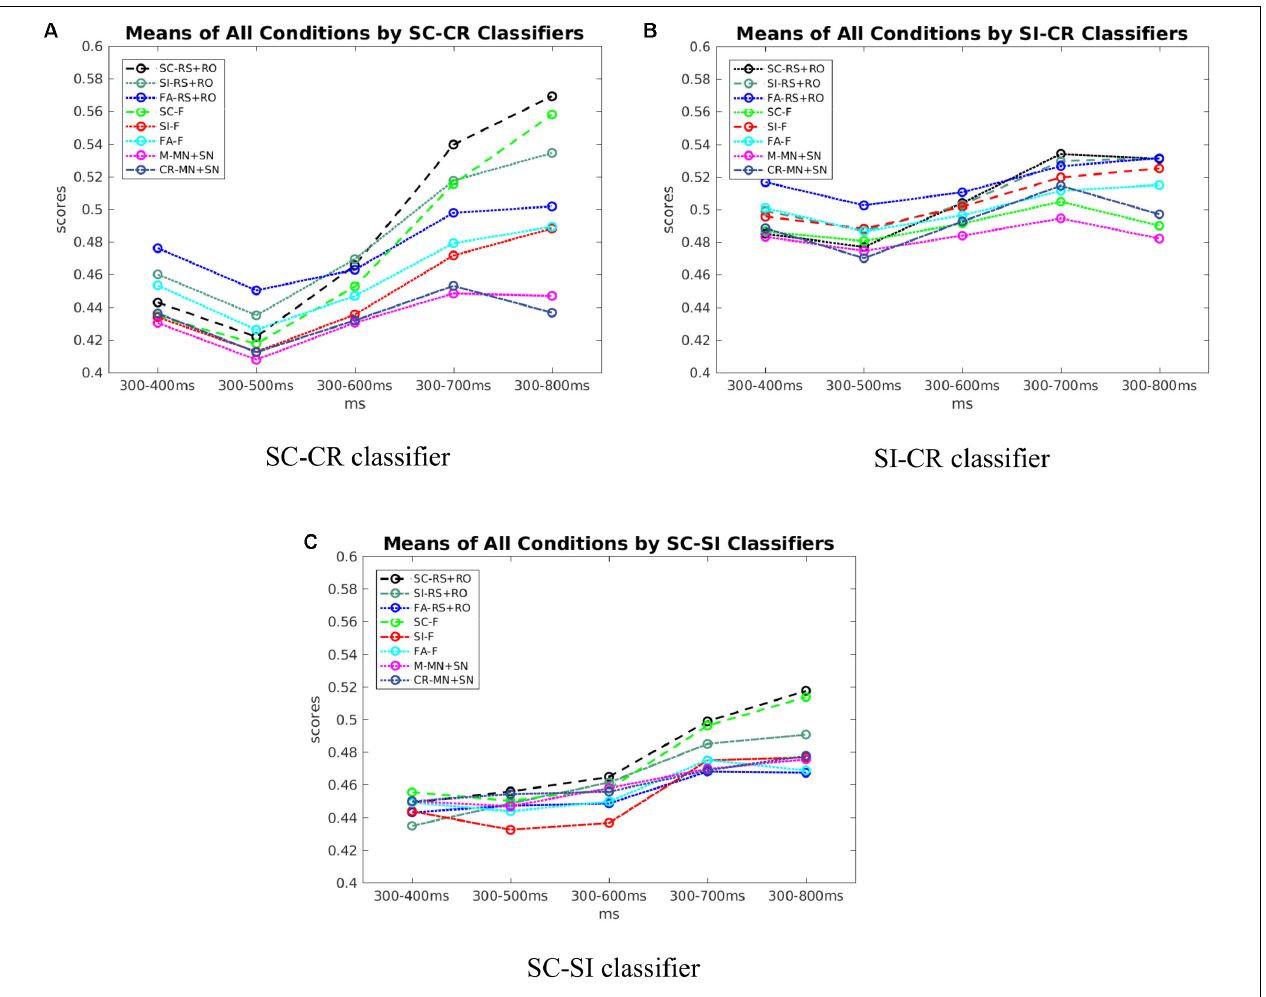
FIGURE 9 | (A) The scores of all conditions across time by SC-CR classifiers. (B) The scores of all conditions across time by SI-CR classifiers. (C) The scores of all conditions across time by SC-SI